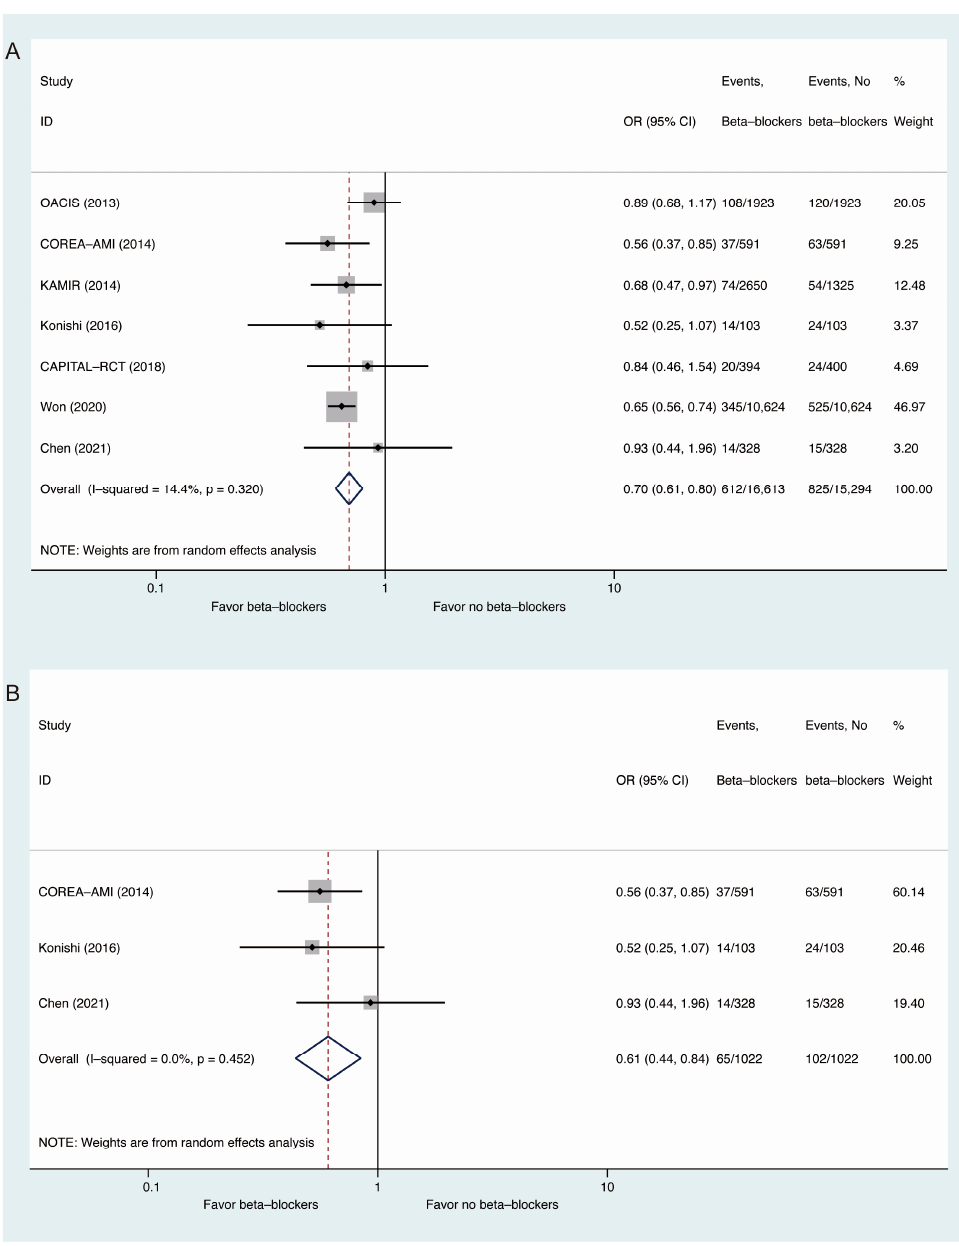
Figure 2. Comparisons of All-Cause Mortality Between Beta-Blockers and Controls: ( A ) whole pop- ulations; ( B ) populations with preserved left ventricular